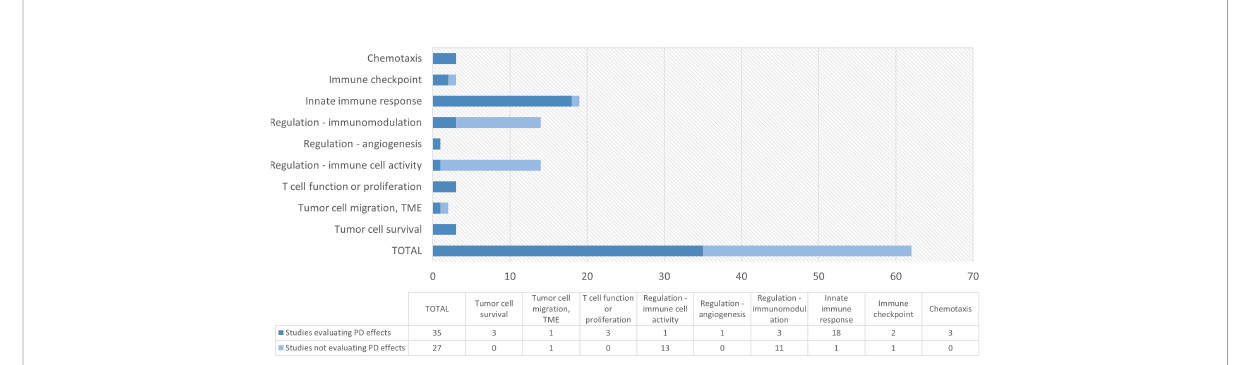
FIGURE 2 Overview of number of studies with at least one pharmacodynamic (PD) endpoint per target group. Targets included in each category are 1) chemotaxis: CXC4 antagonists; 2) immune checkpoint: A2a and A2a/A2b antagonists; 3) innate immune response: CXCR2 antagonist, dectin receptor agonist, TLR3/4/7/8/9 agonists, IFN; 4) Regulation – immunomodulation: CRBN modulators; 5) Regulation – angiogenesis: IL-3; 6) Regulation – immune cell activity: CCR5 antagonists; 7) T cell function or proliferation: anti-CD38 mAb, IL-1R antagonist, IL-10 agonist; 8) Tumor cell migration: TGF- b R1 Kinase/ALK5 inhibitor, P2X7 antagonist; 9) Tumor cell survival: TYK2/JAK1 inhibitor, JAK1/JAK2 inhibitor; PD, pharmacodynamic; TME: tumor